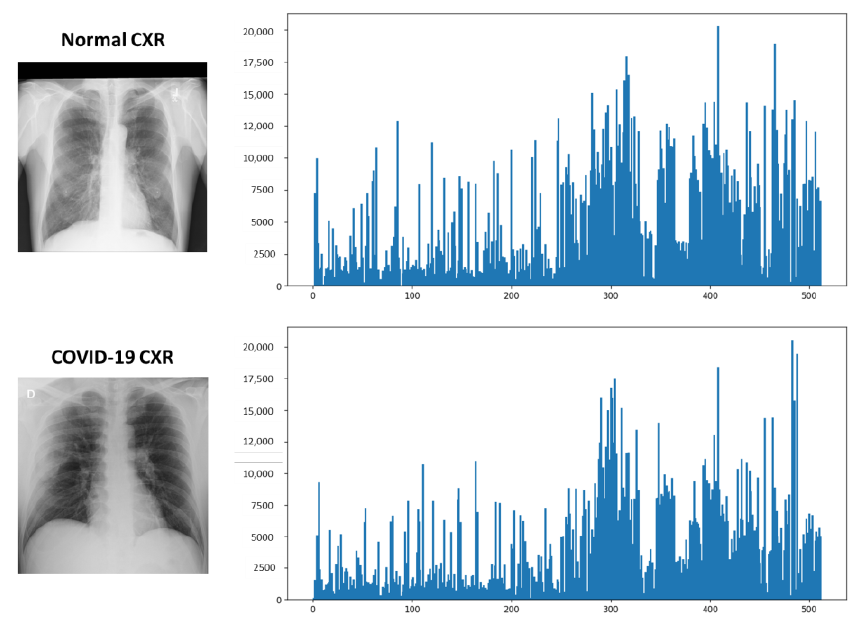
Figure 4. Sample CXRs and their corresponding feature vectors.